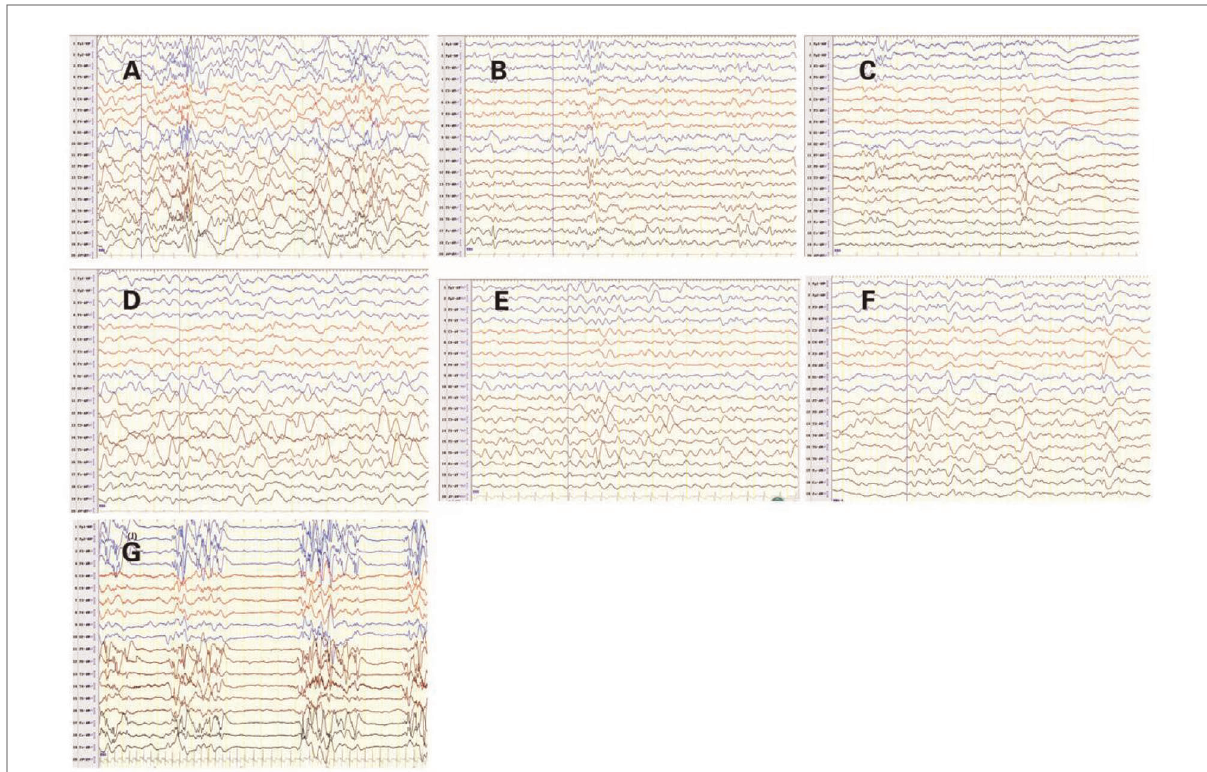
FIGURE 2 Initial electroencephalograms of patients with syntaxin-binding protein 1 (STXBP1) mutations. ( A ) Patient2 1year and 1months, Multifocal spikes and slow waves during sleep status. ( B ) Patient3 1year and 5months, slow background, multifocal slow waves. ( C ) Patient4 2 months and 29 days, spasms and focal epileptic activities originating from the left Anterior and middle temporal area. ( D ) Patient5 1 year and 2 months, slow background and Slow wave activity originating from the left middle and posterior temporal regions. ( E ) Patient6 9 months and 10days, sharp-slow waves originating from the right Posterior temporal area during sleep status on interictal EEG. ( F ) Patient7 8 months and 20 days, slow and spikes-slow waves originating from bilateral Parietal, Occipital, mid-posterior temporal areas during sleep status. ( G ) Patient10 1 months, burst suppression